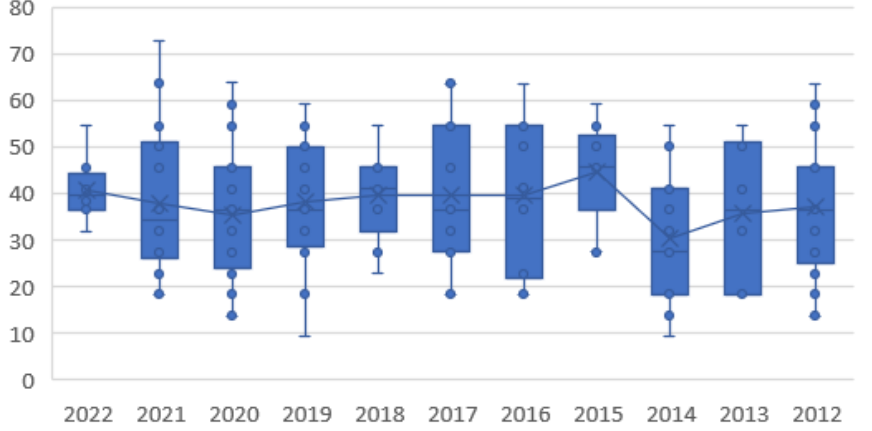
Figure 1. Variation of the OConfidence throughout the years .